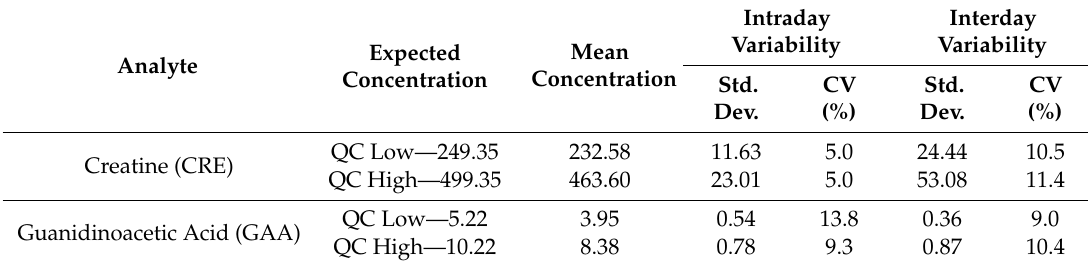
Table 3. Intraday and interday variability of GAMT QC materials via AAAC-GAMT non-derivatized assay ( n = 40). Units: µ M